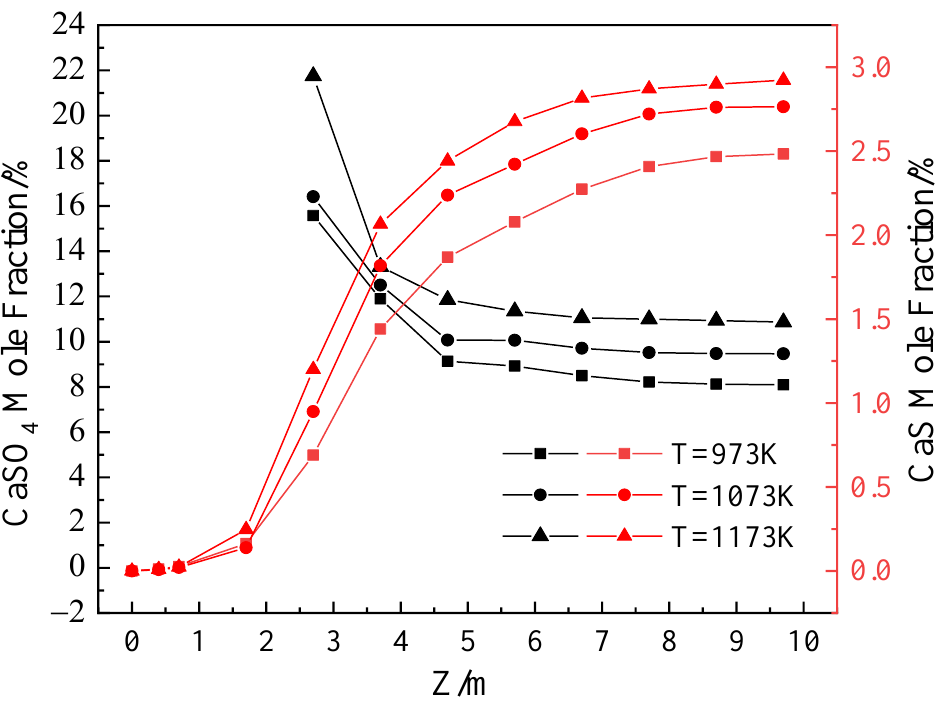
Figure 15. Curve chart of average molar fraction of solid phase at each section in the Z-axis at different flue gas temperatures.